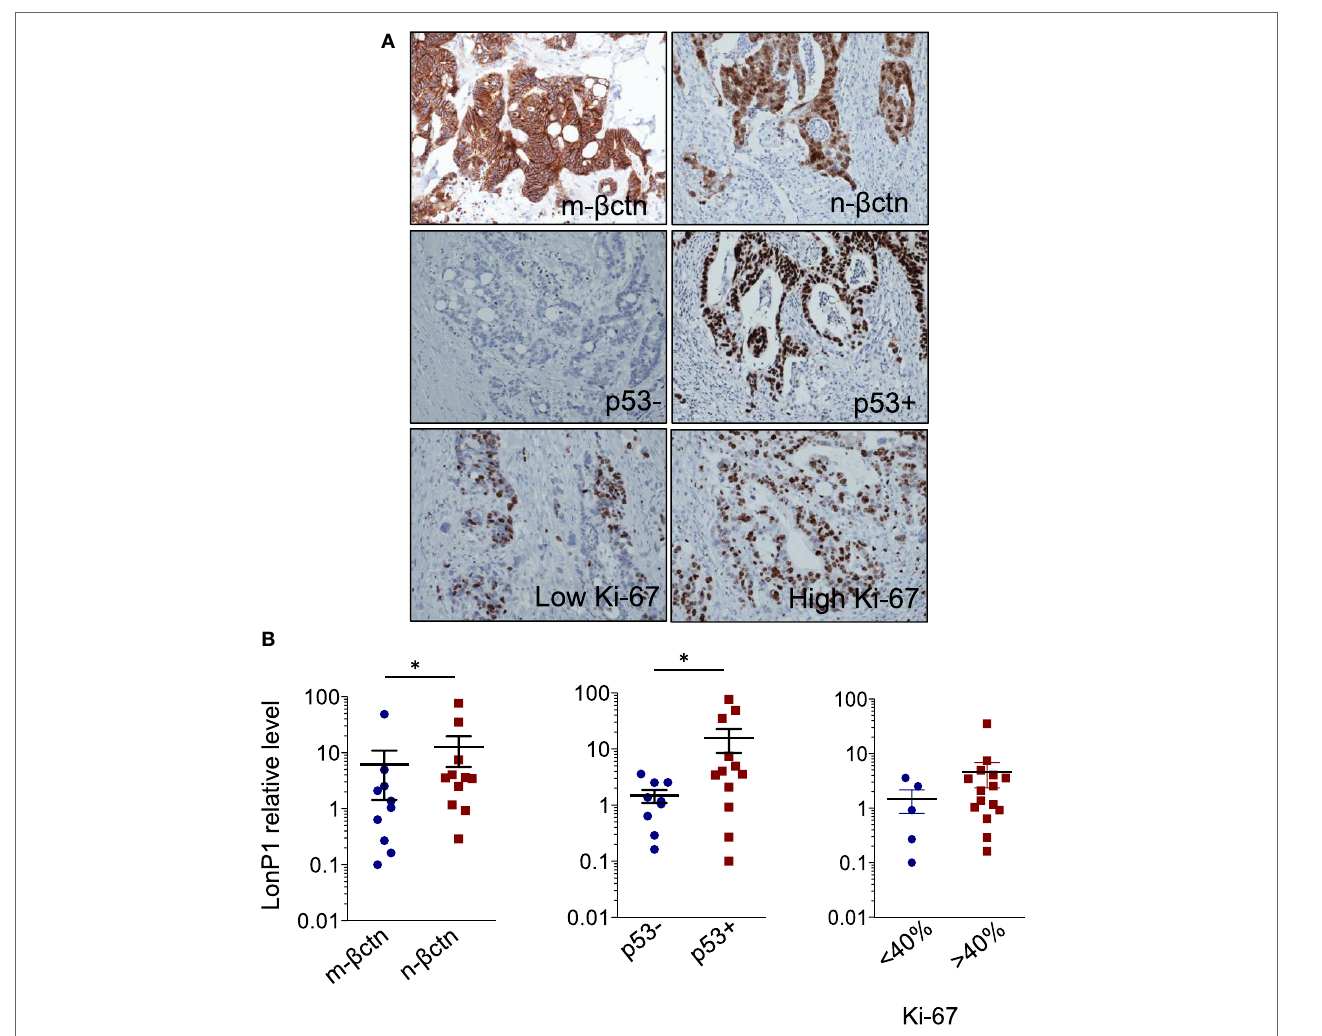
FigUre 3 | LonP1 upregulation is associated with mutated p53 or nuclear β -ctn. (a) Representative immunohistochemical stainings of Ki-67, membrane β -ctn (m- β ctn), nuclear β -ctn (n- β ctn), and p53 in colorectal cancer (CRC) tissues. (B) Association between expression of LonP1, mutated p53, non-mutated p53, membrane β -ctn, or nuclear β -ctn in CRC tissues; * P <